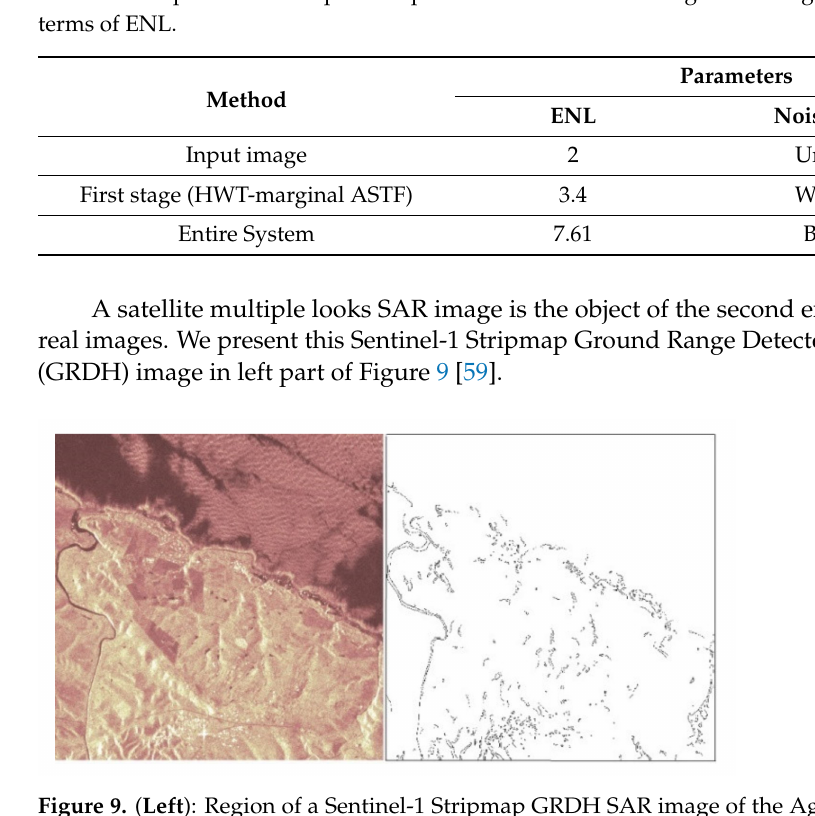
Figure 9. ( Left ): Region of a Sentinel-1 Stripmap GRDH SAR image of the Agulhas current ocean registered the 11-03-2015; ( Right ): Result obtained applying the Canny’s edge detection